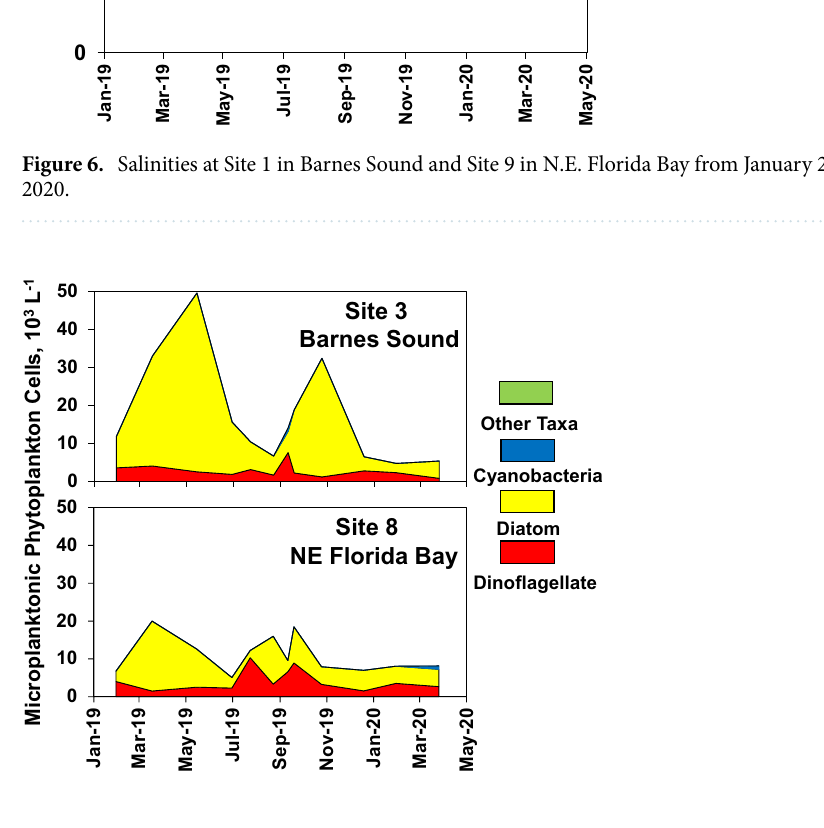
Figure 7. Examples of composition of microplanktonic phytoplankton (i.e. 20–200 µm) in Barnes Sound and NE Florida Bay in terms of cell density over the period when polystyrene microplastic particles were